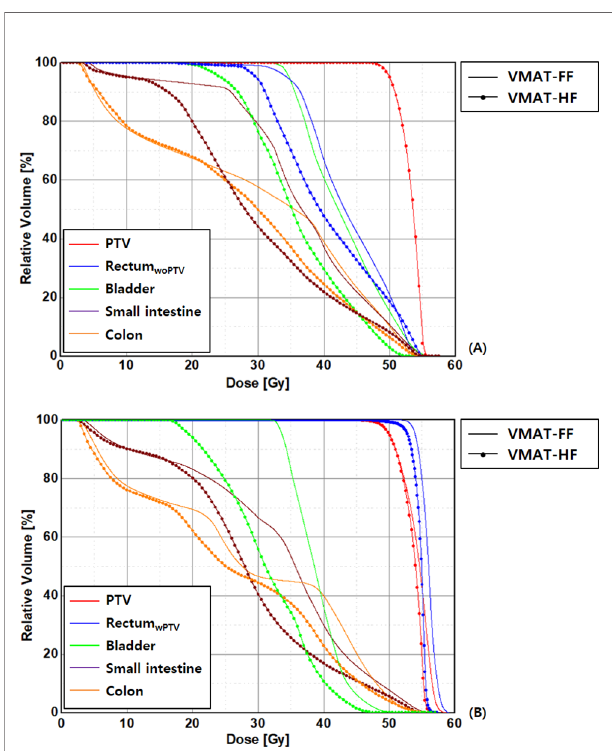
FIGURE 3 | Comparison of dose – volume histograms in patients with anal cancer in the volumetric modulated arc therapy (VMAT) plans optimized using a fully opened fi eld size (FF) and a half-beam technique (HF), as rectal volume is (A) overlapped (rectum wPTV ) and (B) not overlapped (rectum woPTV ) with planning target volumes. TABLE 4 | Comparison of dose – volume parameters for the small bowel, colon, rectum, and bladder in the volumetric modulated arc therapy (VMAT) plans